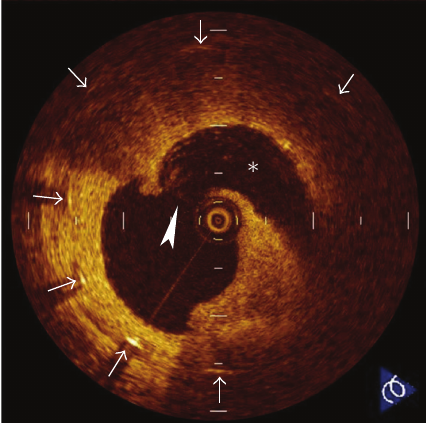
Figure 6: Neointimal plaque rupture. A 71-year-old male was admitted to our hospital with very late ( > 10 years) bare-metal stent thrombosis. OCT disclosed a plaque rupture (arrowhead) and cavity formation ( ∗ ) within neointima in the stented segment